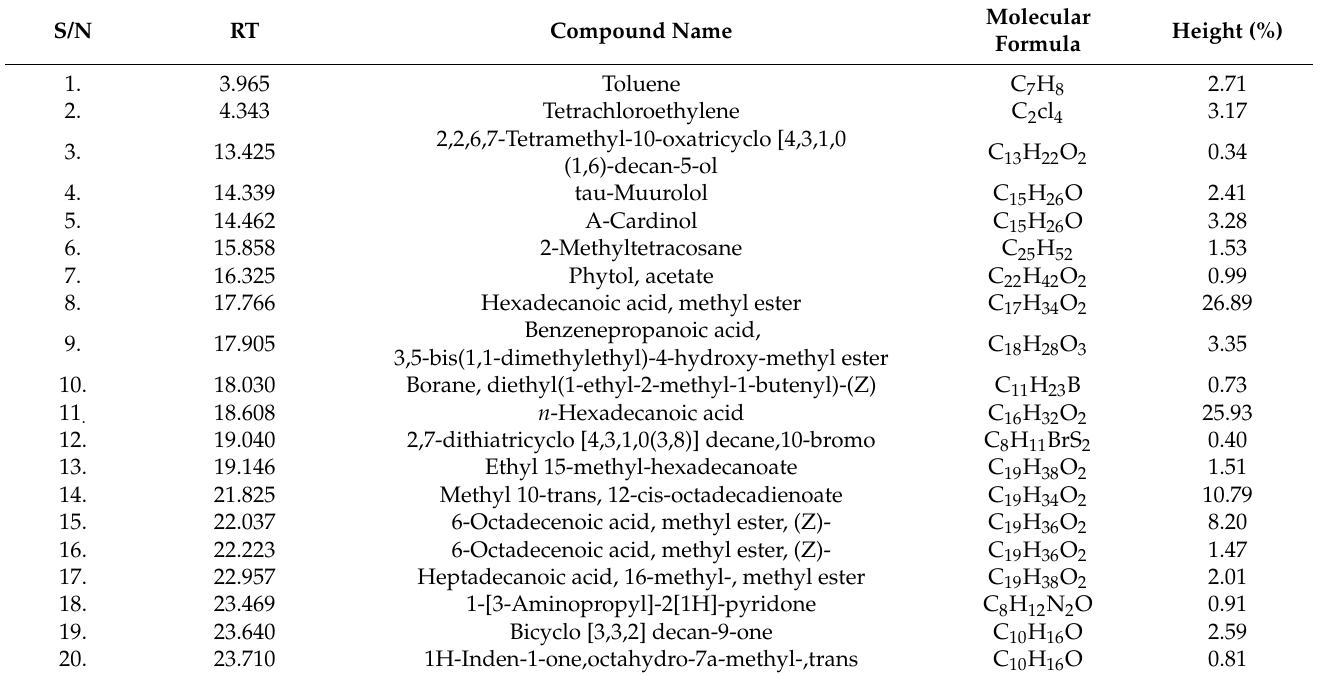
Table 6. Compounds identified in the methanol extracts of D. villosa stem by GC–MS spectral analysis.